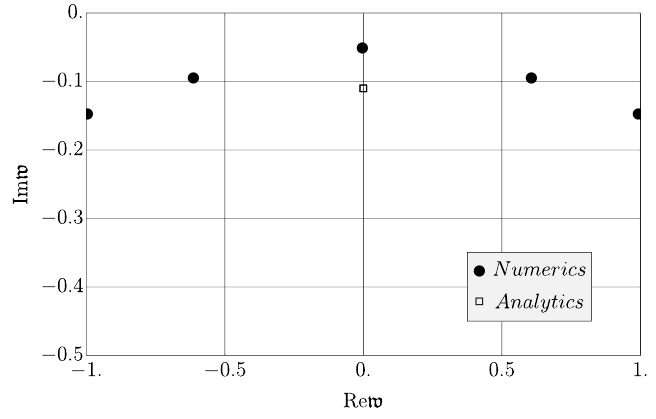
Figure 1 . The poles of the scalar channel Green’s function G R in the complex frequency plane at q = 0 : 1 and (cid:21) The poles found numerically are shown by black circles. The white square shows the analytic approximation (2.44) to the location of the pole on the imaginary